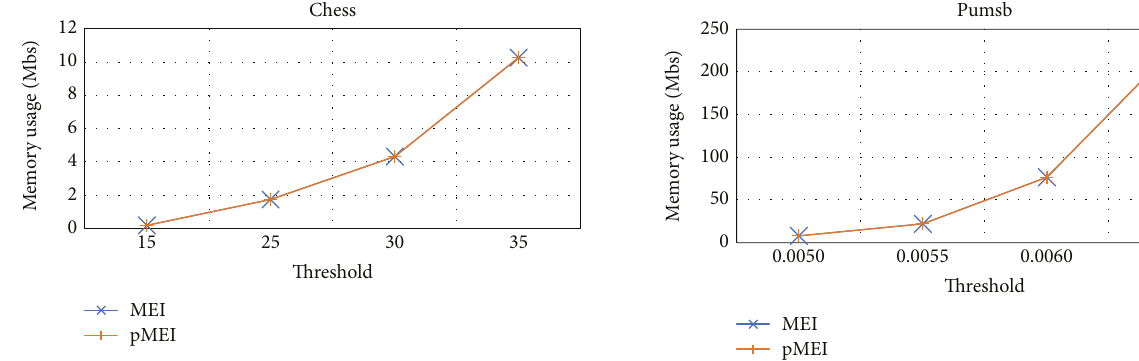
Figure 12: Memory usage of the MEI and pMEI methods on the Pumsb.